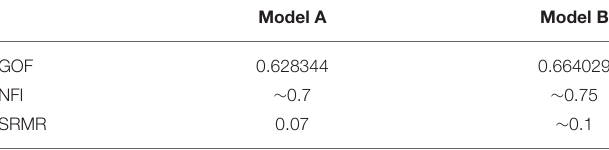
TABLE 10 | Index of fit.